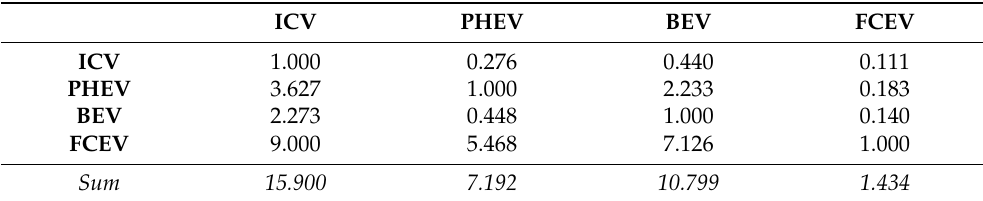
Table 7. Standard matrix of importance ratios between alternatives for the GWP criterion. ICV PHEV BEV FCEV Priority ICV 0.063